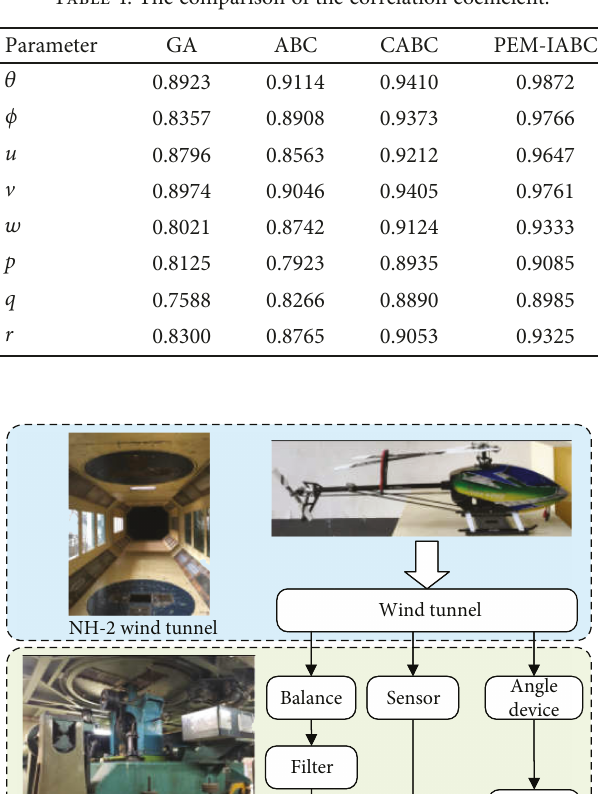
Table 4: The comparison of the correlation coe ffi cient.